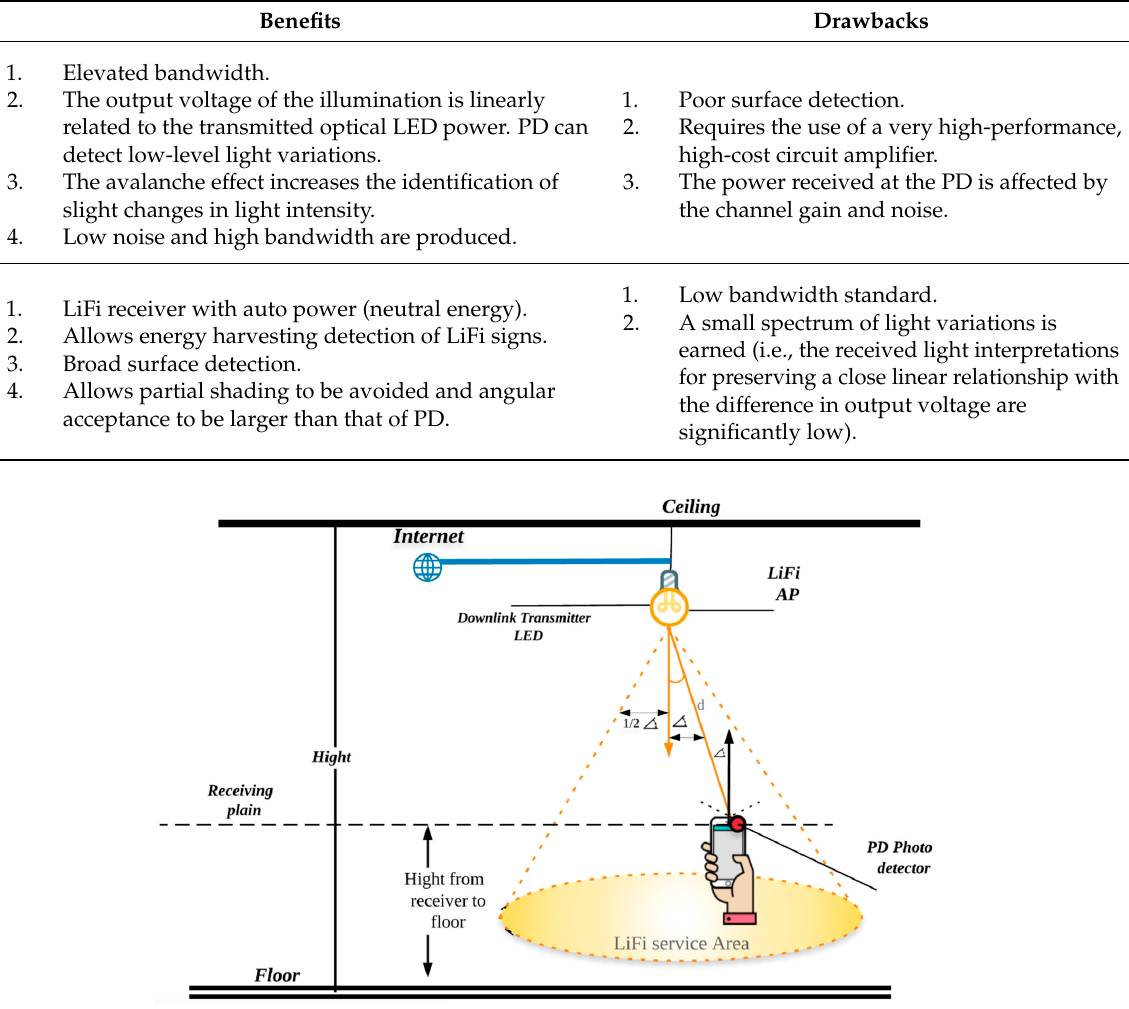
Figure 6. DLT and DLR in a room scenario.